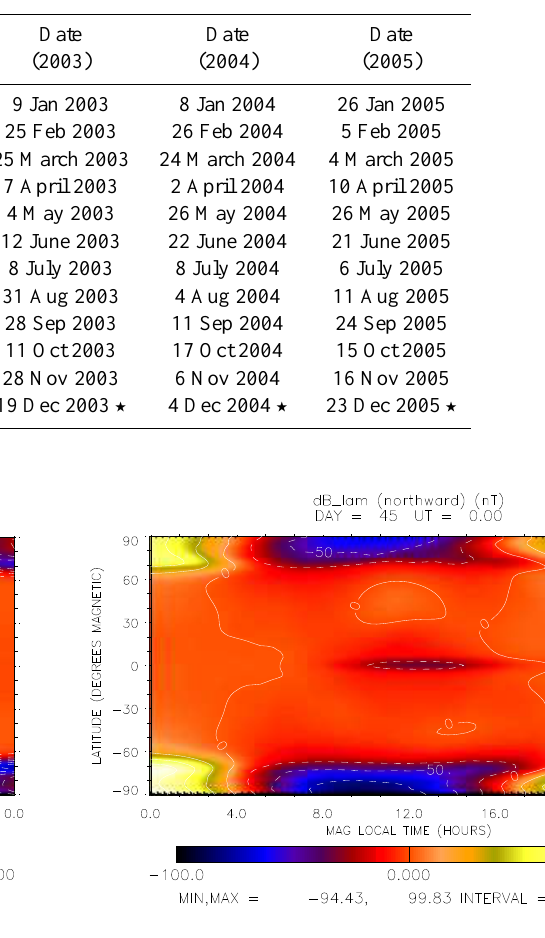
Fig. 3. The northward component of the magnetic perturbation in units of nT predicted by the TIE-GCM for 14 February 2002 using GPI